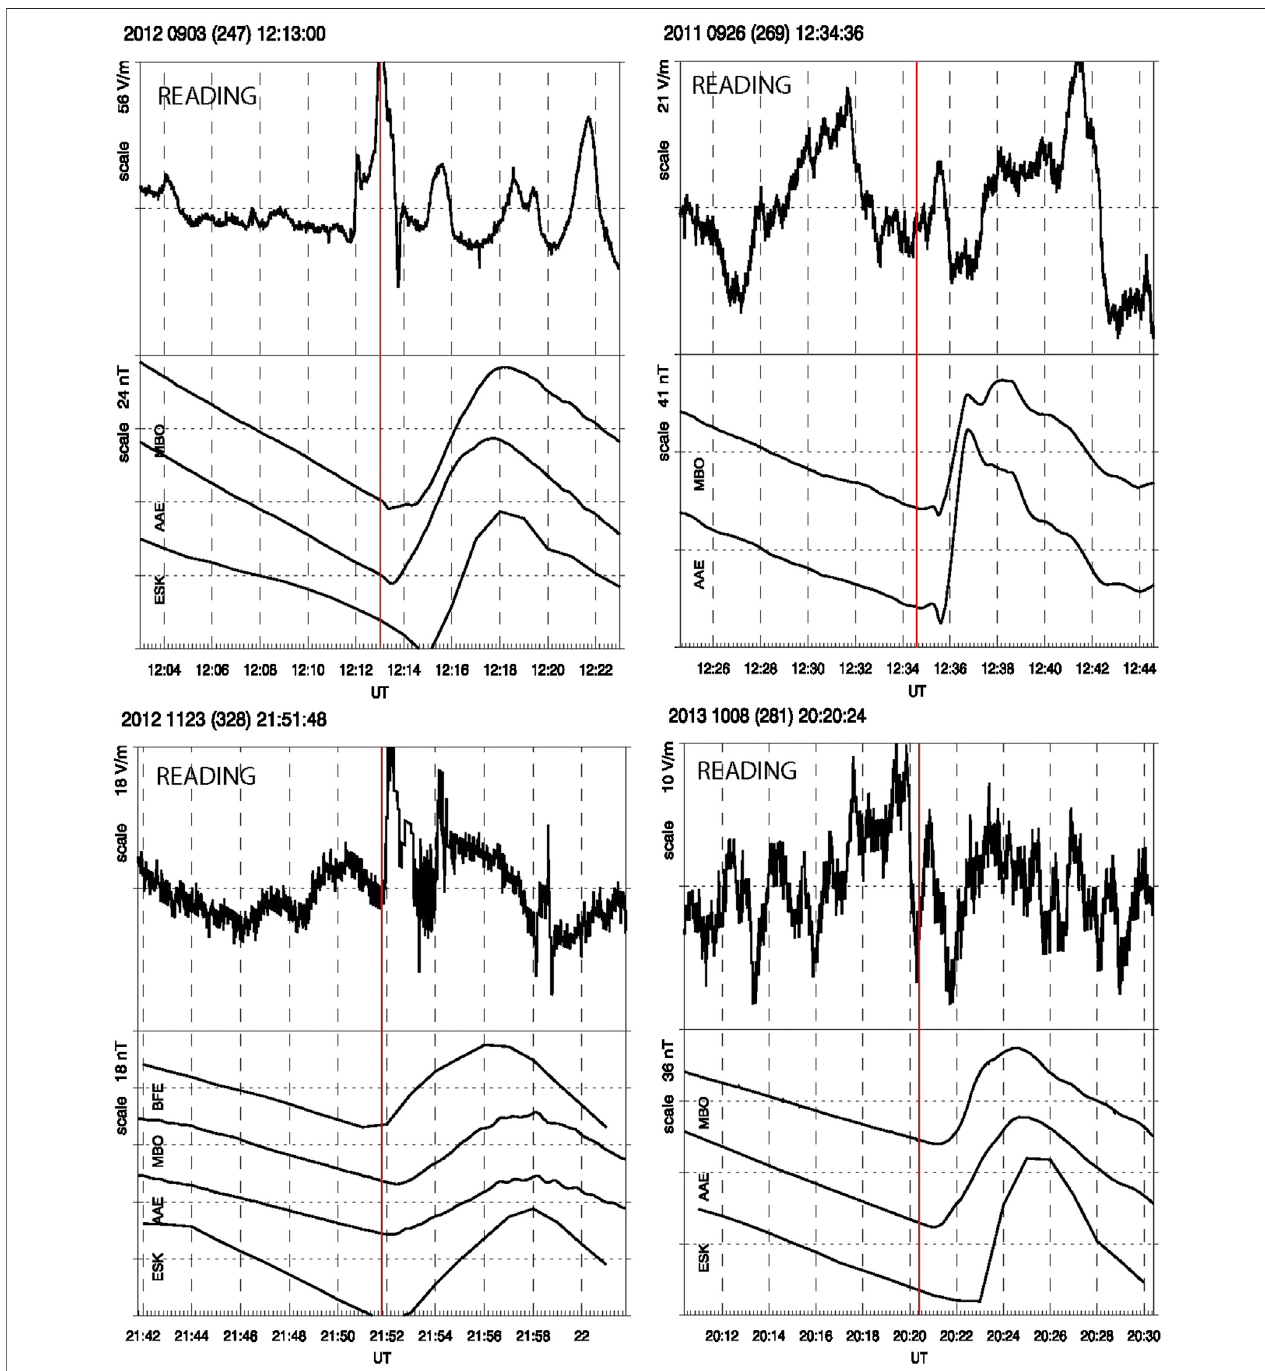
FIGURE 2 | Four events with seemingly bursts of E z during SSC. Upper panels show variations of the atmospheric potential gradient, E z , and bottom panel shows magnetograms (X component) from magnetometers in the same LT sector.